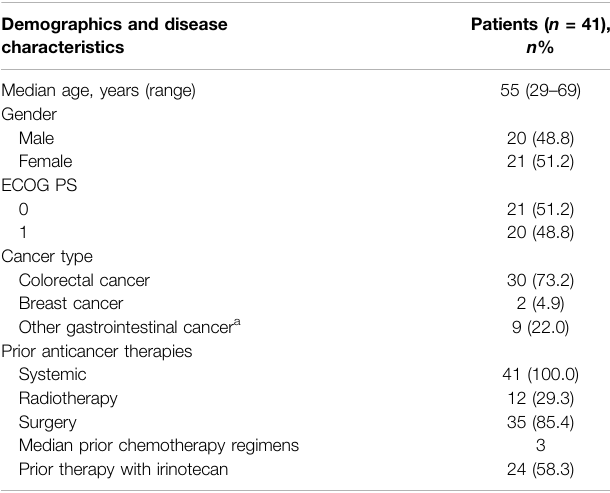
TABLE 2 | Baseline